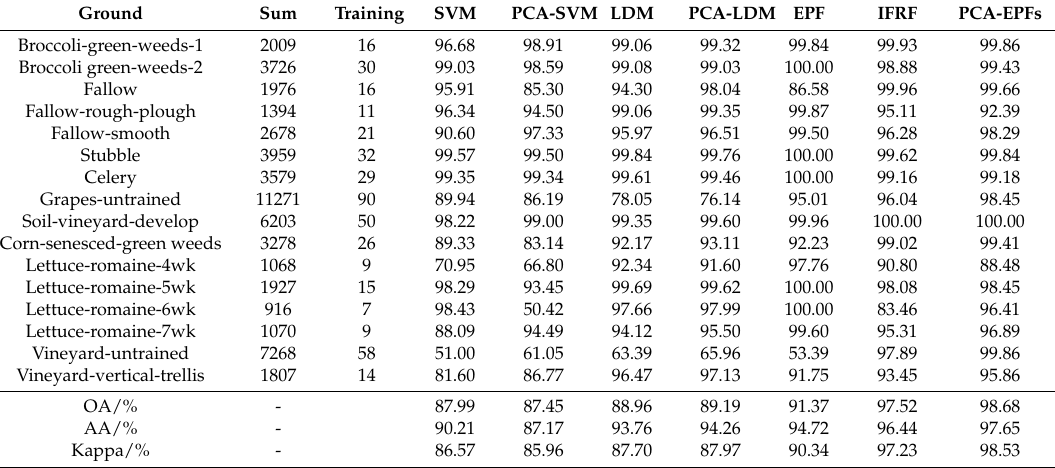
Table 3. Comparison of classification accuracies (in percent) provided by seven methods for Salinas Valley (part